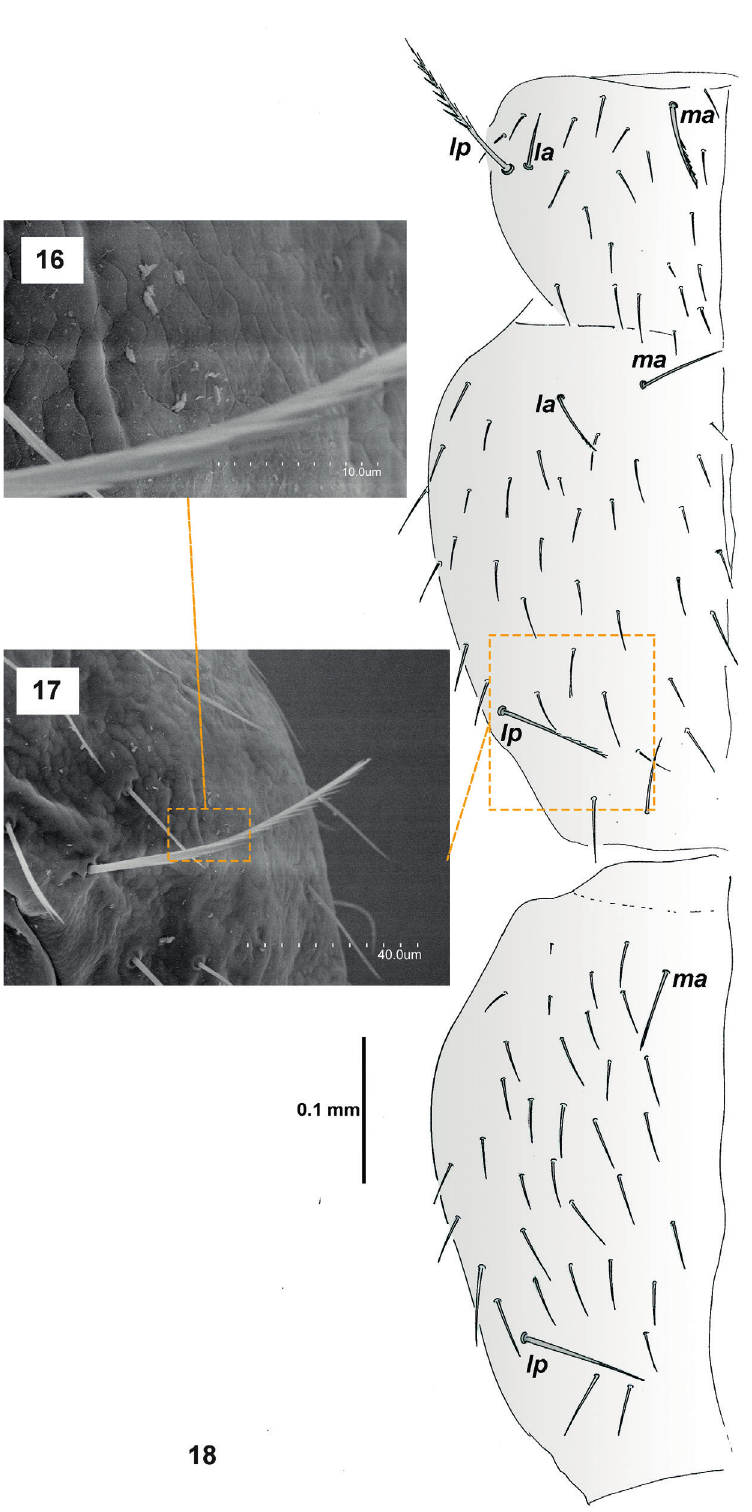
Figs 16−18. Kyrgyzstancampa sanare Sendra & Ferreira gen. et sp. nov. 16 . ♂, paratype (Coll. AS), detail of mesonotum. 17 . ♂, paratype (Coll. AS), detail of lateral posterior mesonotum. 18 . ♀, holotype (IBB 92101), thoracic